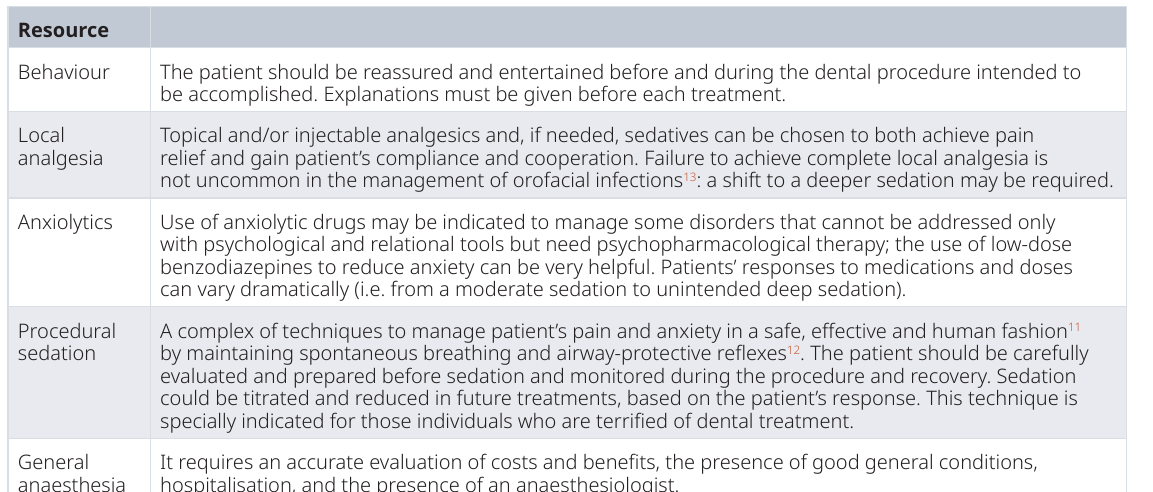
Table 1. Basic resources for the patient-centered